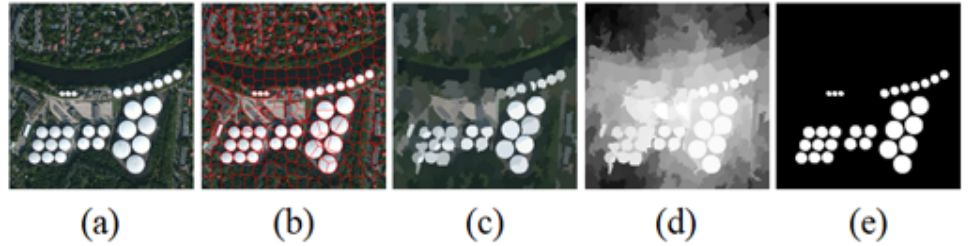
Figure 2. An example of the process of a Color Markov Chain. ( a ) is the input image, ( b ) is the super-pixel segmentation, ( c ) is the result after averaging, ( d ) is the result of the Color Markov Chain, and ( e ) is the ground